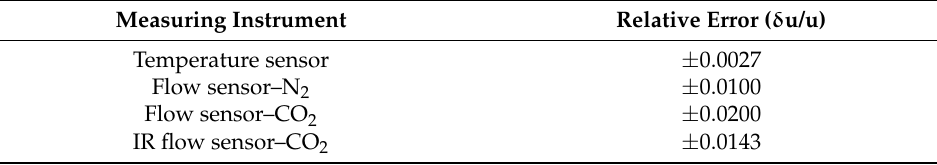
Table 1. Sensitivity of the sensors used for measurements.